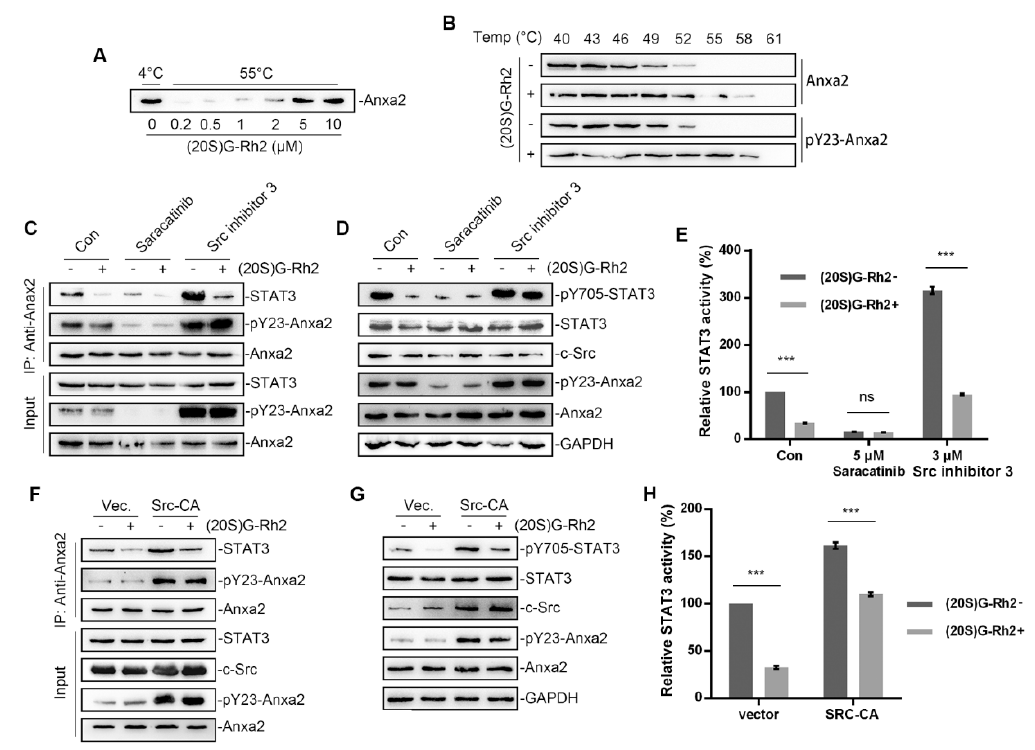
Figure 3. (20S)G-Rh2 inhibited STAT3 activation by targeting Anxa2. ( A ) Thermal shift assay was performed with purified Anxa2 and (20S)G-Rh2 gradient at 55 ◦ C, and determined by immuno-blotting. ( B ) Cellular thermal shift assay was performed in HepG2 cells with indicated temperature gradient and determined by immuno-blotting. ( C – E ) HepG2 cells were treated with Src inhibitor (Saracatinib), Src activator (Src inhibitor 3) or (20S)G-Rh2, or under co-treatment. Immuno-precipitation with anti-Anxa2 antibody ( C ) and protein level ( D ) were determined by immuno-blotting. STAT3 activation was determined via reporter gene assay ( E ). ( F – H ) HepG2 cells were transfected with the constitutively activated mutant of Src and treated with (20S)G-Rh2. Immuno-precipitation with anti-Anxa2 antibody ( F ) and protein level ( G ) were determined by immuno-blotting. STAT3 activation was determined via reporter gene assay ( H ). All experiments were performed with triple replicant. Significance analysis was shown as ns ( p > 0.05) and *** ( p < 0.001).